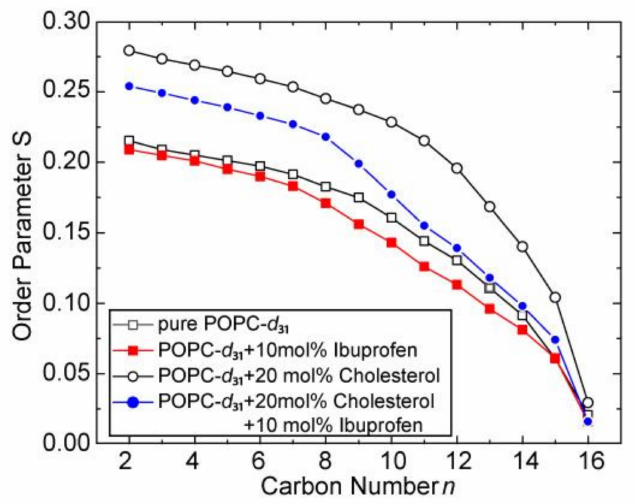
Figure 2. 2 H-NMR chain order parameters plots of POPC- d 31 in the absence and in the presence of 10 mol% ibuprofen and / or 20 mol%